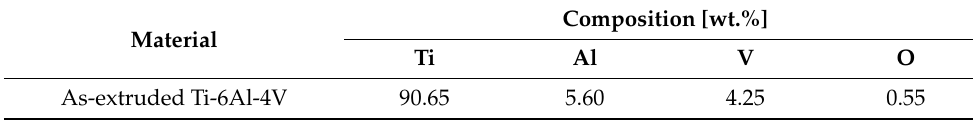
Table 2. Measured chemical composition and oxygen content of the extruded Ti-6Al-4V bar. Composition [wt.%] Material Ti Al As-extruded